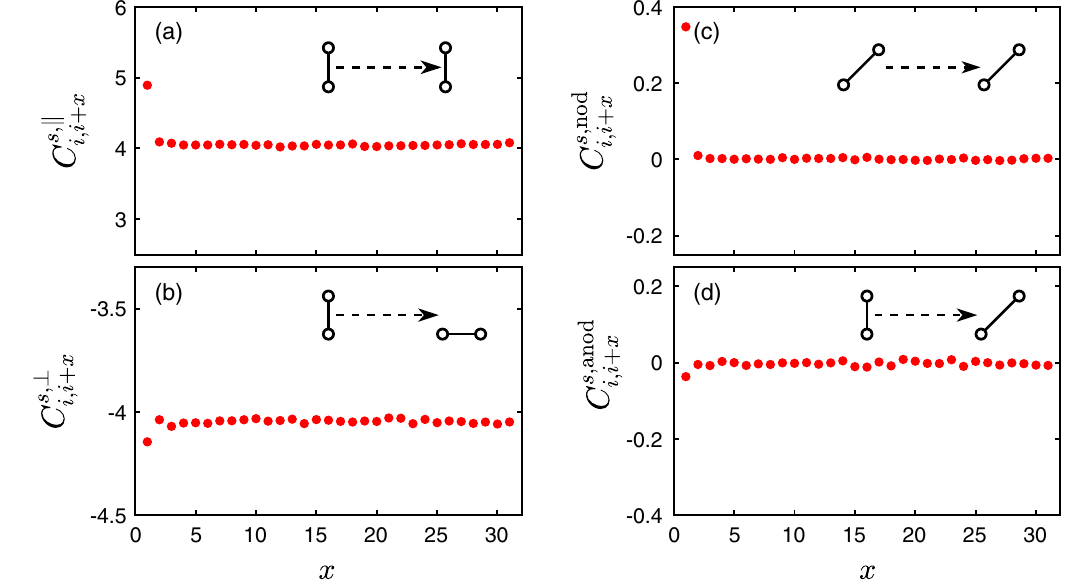
; while i;j N = 4 ; i N = 4 with the x ¼ x y ¼ y